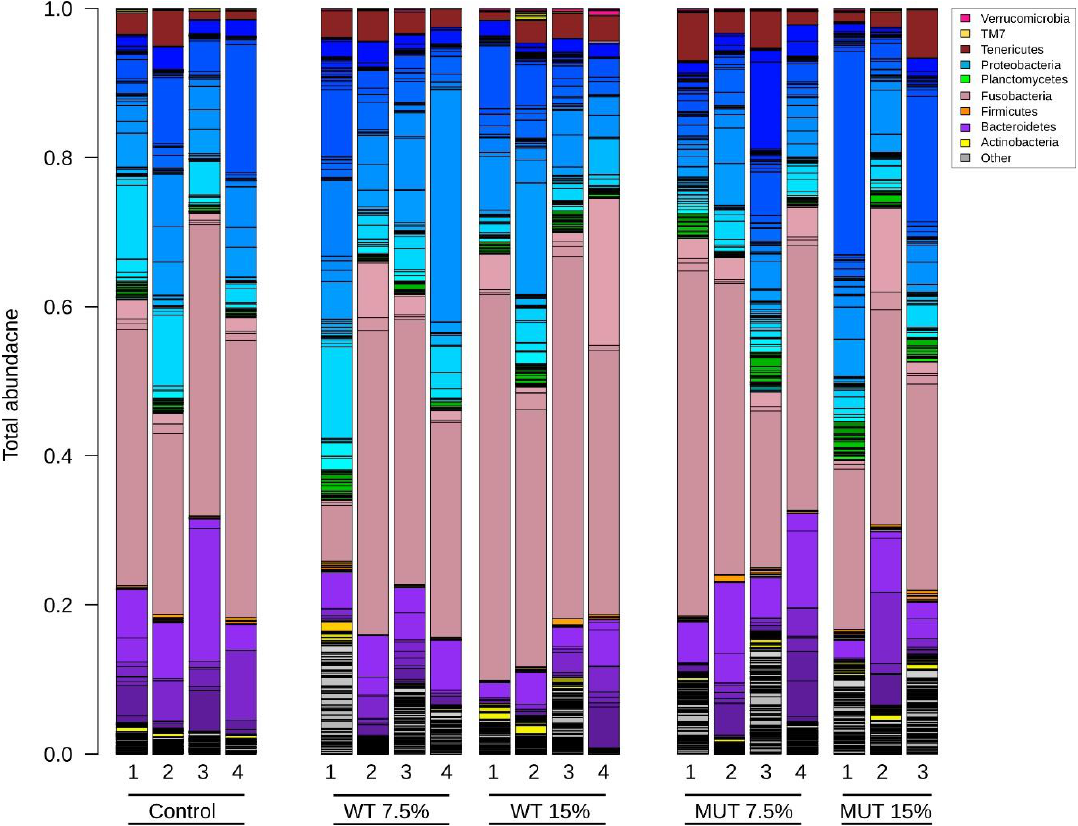
Figure 7. Total microbial community composition in zebrafish fed the different diets. Different colors in each bar represent the different bacterial phylum compositions, while shades of the same color represent different OTUs within the same phyla. Control, nonsupplemented diet; WT, diet supplemented with wild-type Lobosphaera incisa ; MUT, diet supplemented with mutant strain of L. incisa .